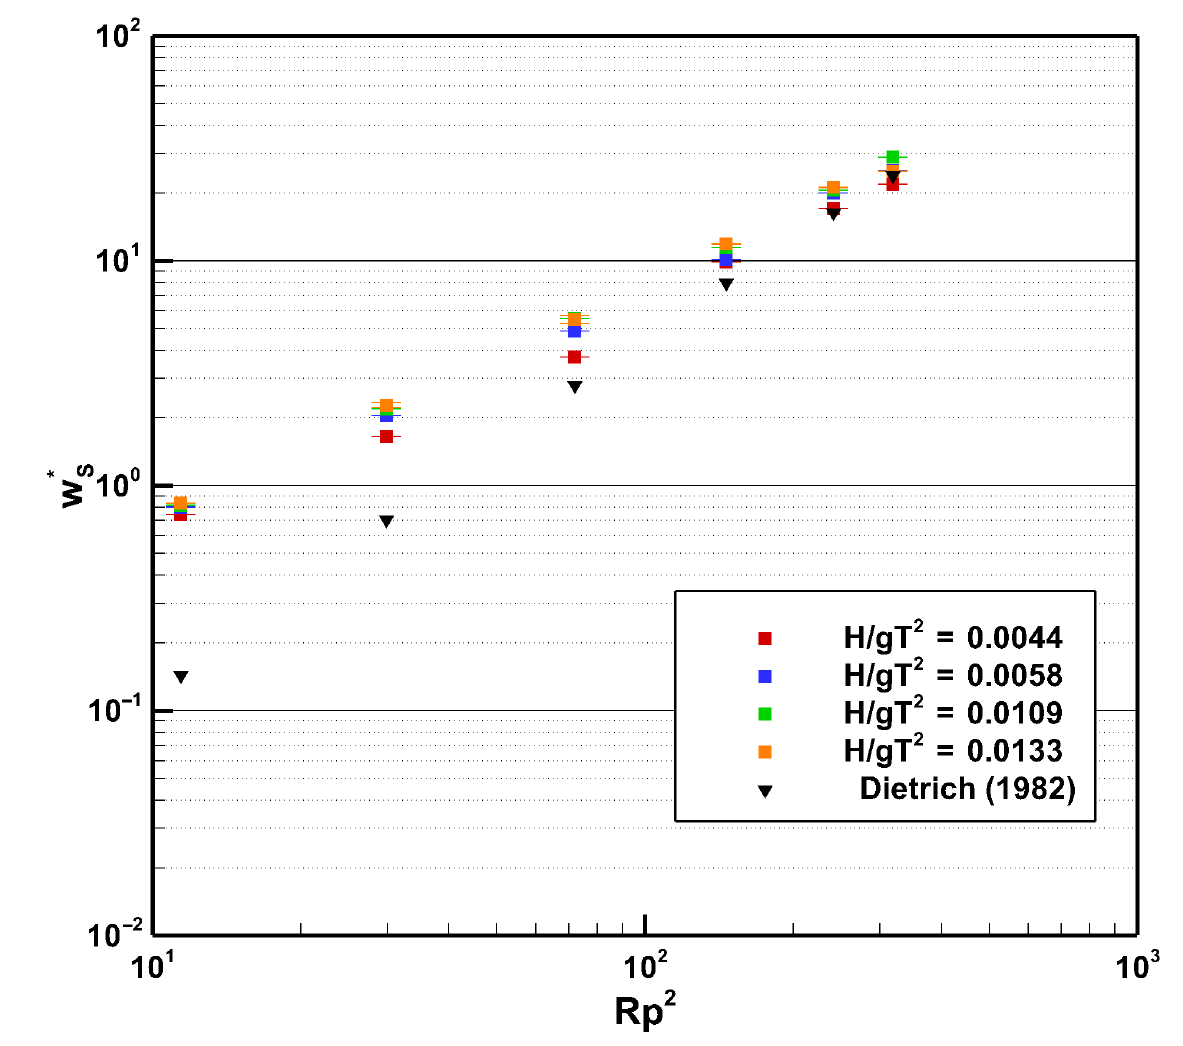
Figure 6. Non-dimensional net settling velocity w ∗ s as a function of the squared particle Reynolds